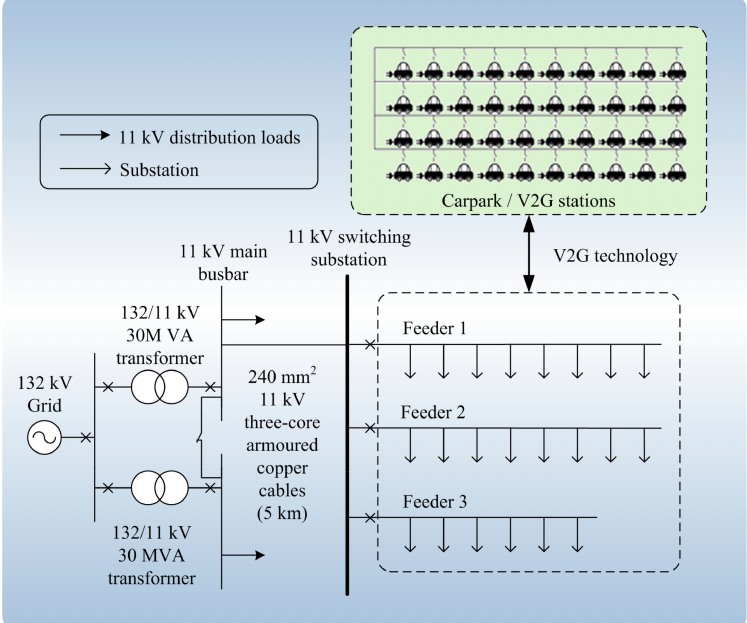
Figure 2. Single-line diagram of a generic